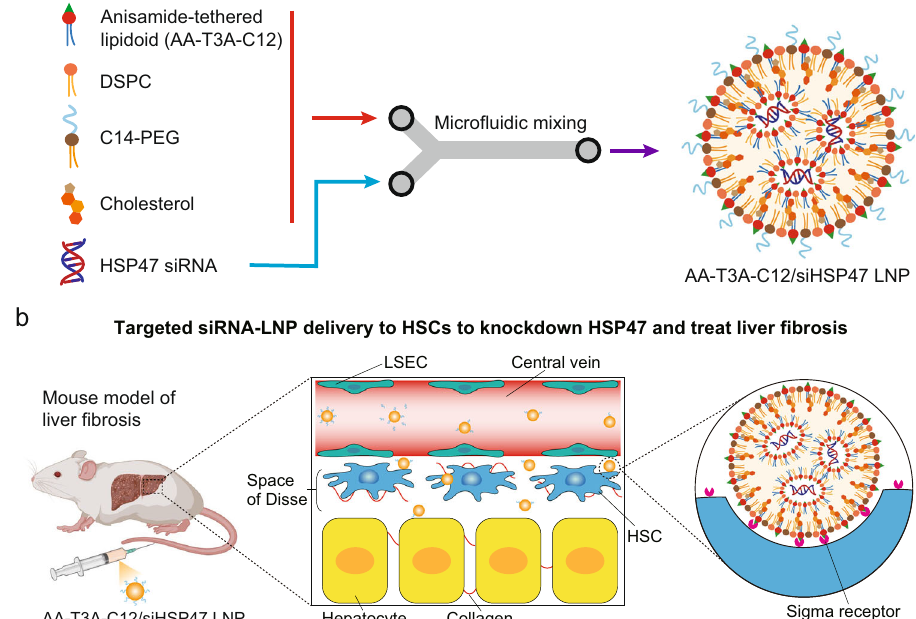
b Scheme of targeted AA-T3A-C12/siHSP47 LNP delivery to activated HSCs to knockdownHSP47andtreatliver fi brosis.HSCsarelocatedinthespaceofDisse,an areabetweenLSECsandhepatocytes.AfterrapidlysheddingPEGincirculation,the LNP exposes multivalent anisamide ligands on its surface that can strongly bind with sigmareceptorsoverexpressed on activated HSCs to mediate cellularuptake. b was created with